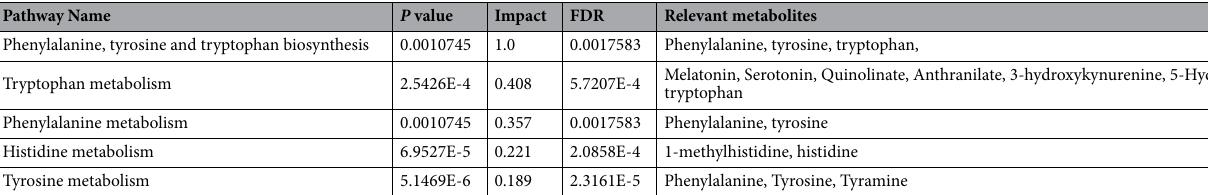
Table 3. Results of pathway analysis with MetaboAnalyst 5.0 indicating potential metabolic pathways to be regulated in the early stage of